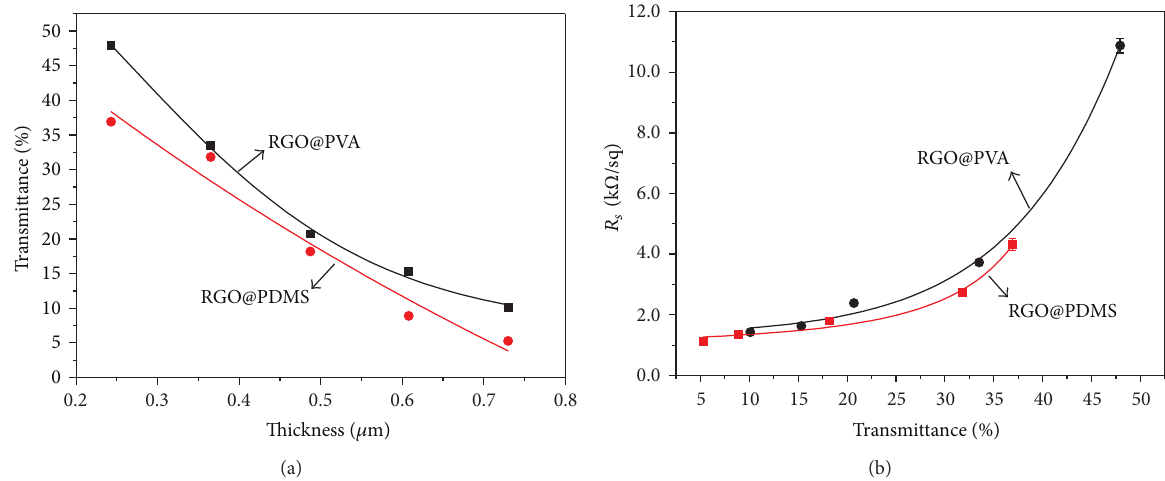
Figure 6: (a) Optical transmittance at 550 nm of the composite films with different thicknesses of RGO; (b) sheet resistance versus optical transmittance at 550 nm of RGO@PVA and RGO@PDMS composite